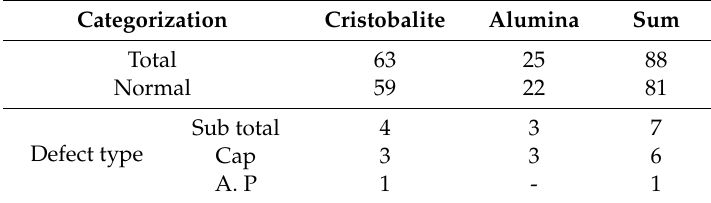
Table 1. Categorization of specimens according to type of material and defect.